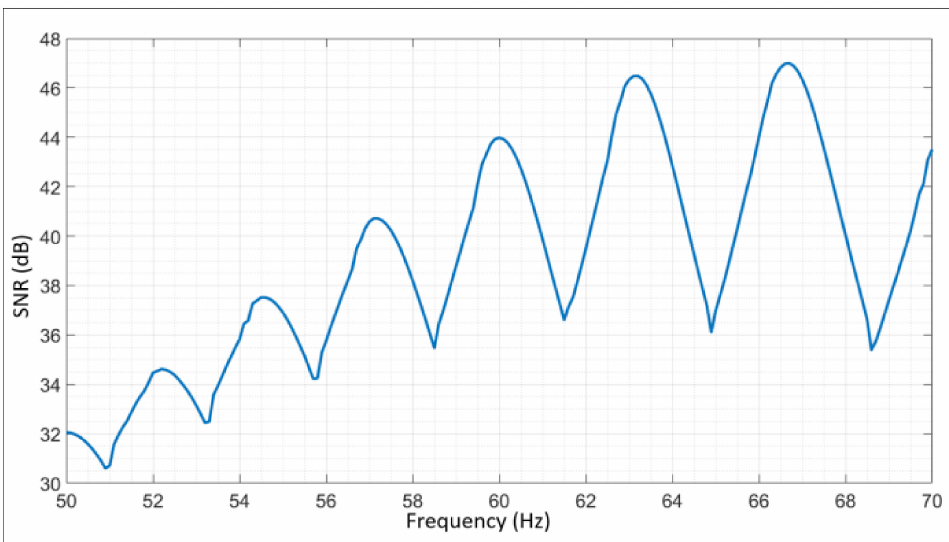
Figure 17. Curve of SNR values in the frequency range of 50 Hz to 70